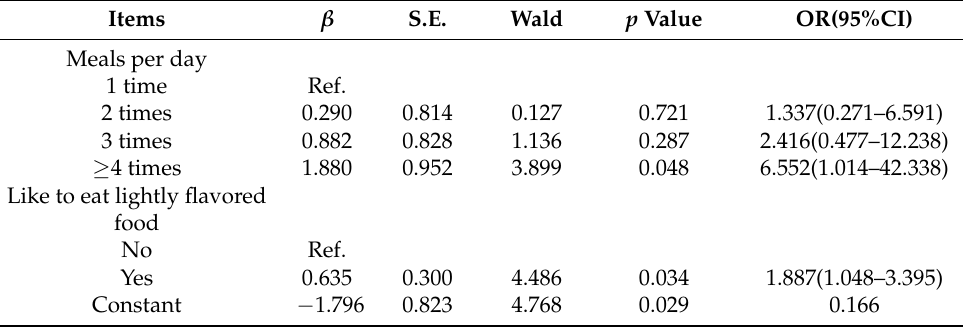
Table 10. Logistic regression analysis of the impact factors of maternal